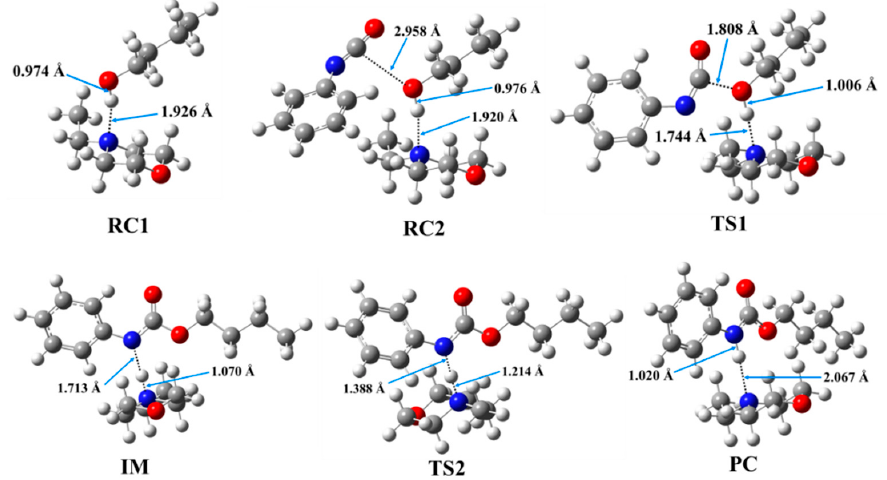
Figure 4. Optimised structures along the reaction pathway between phenyl isocyanate and butan-1-ol in the presence of N -ethylmorpholine (NEM) calculated at the BHandHLYP/6-31G(d) level of theory in acetonitrile at 298.15 K and 1 atm. RC—reactant complex; TS—transition state; IM—intermediate; PC—product